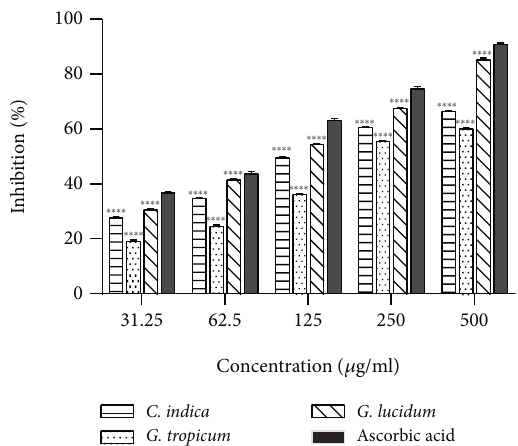
Figure 4: NO radicals scavenging e ff ects of various ethanolic mushroom extracts in comparison with ascorbic acid. Results are expressed as mean ± SD ( n = 3 ). ∗∗∗∗ p < 0 : 0001 vs. standard (ascorbic